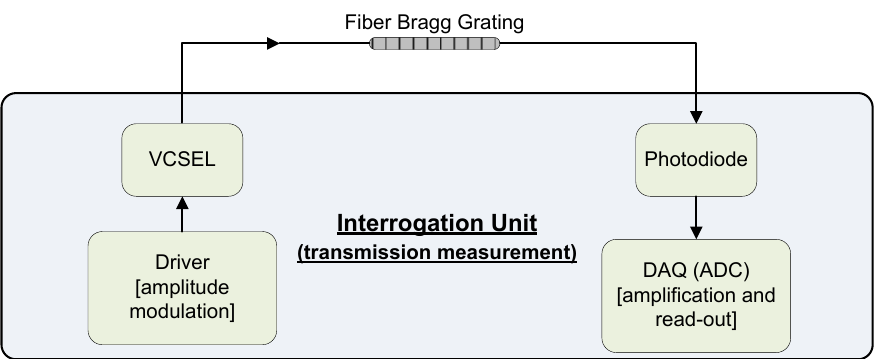
Figure 2. Schematic view of the sensor interrogation